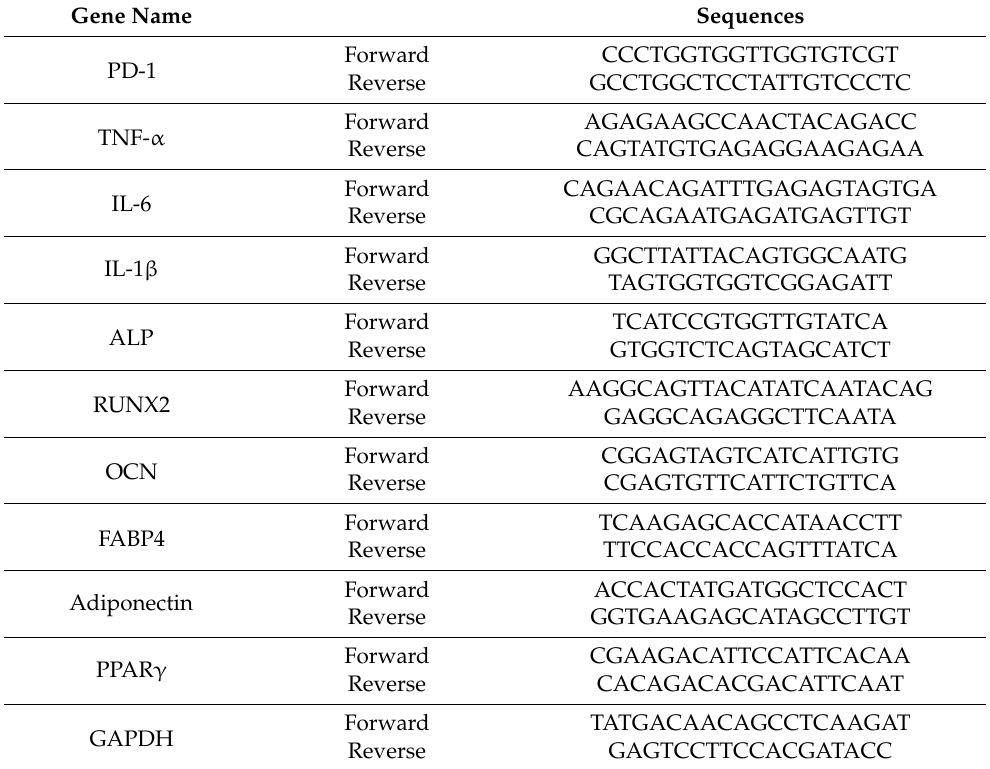
Table 1. List of oligonucleotide primers used in the